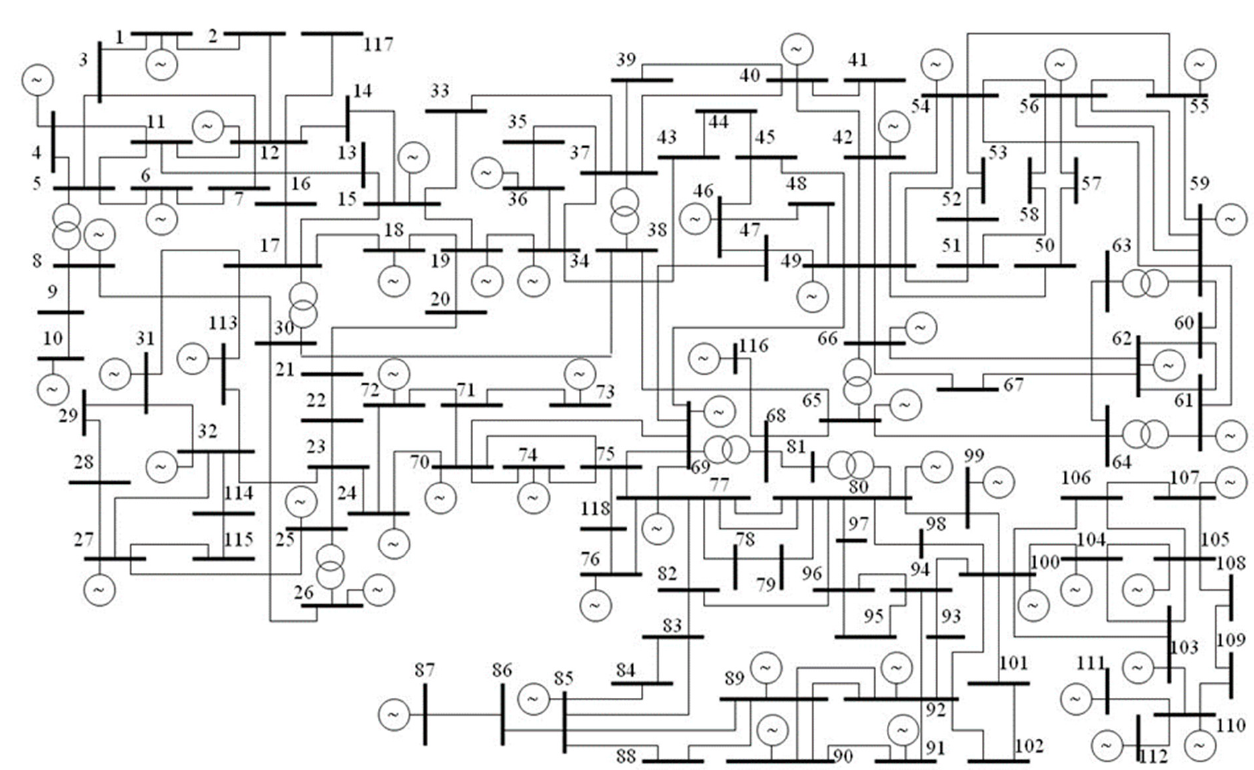
Figure 12. A single-line diagram of the IEEE 118-bus test system. Table 1. Testing